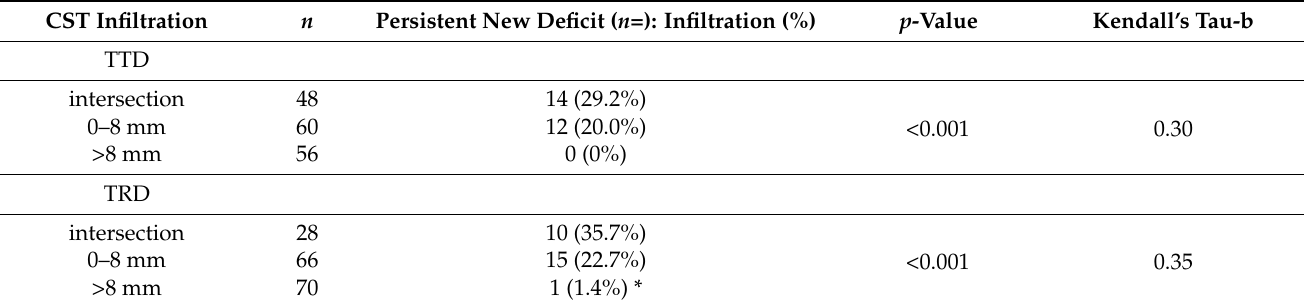
Table 2. Preoperative infiltration of tracts, tract injury, and